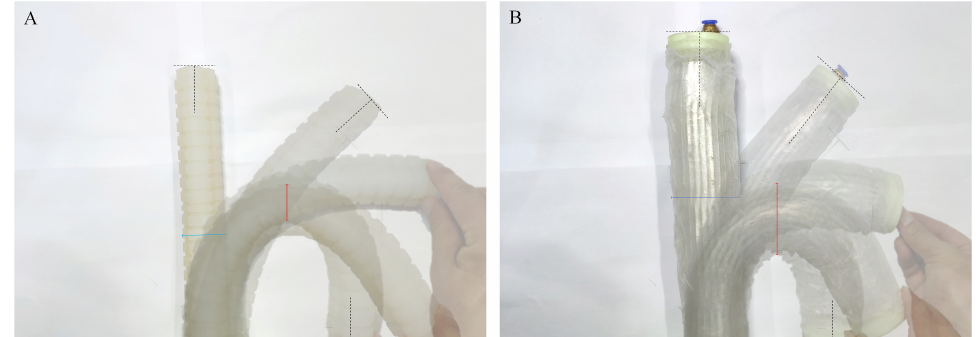
Figure 8. Deformation of centeral diameter under bending. ( A ) Bending experiment of the SCR.